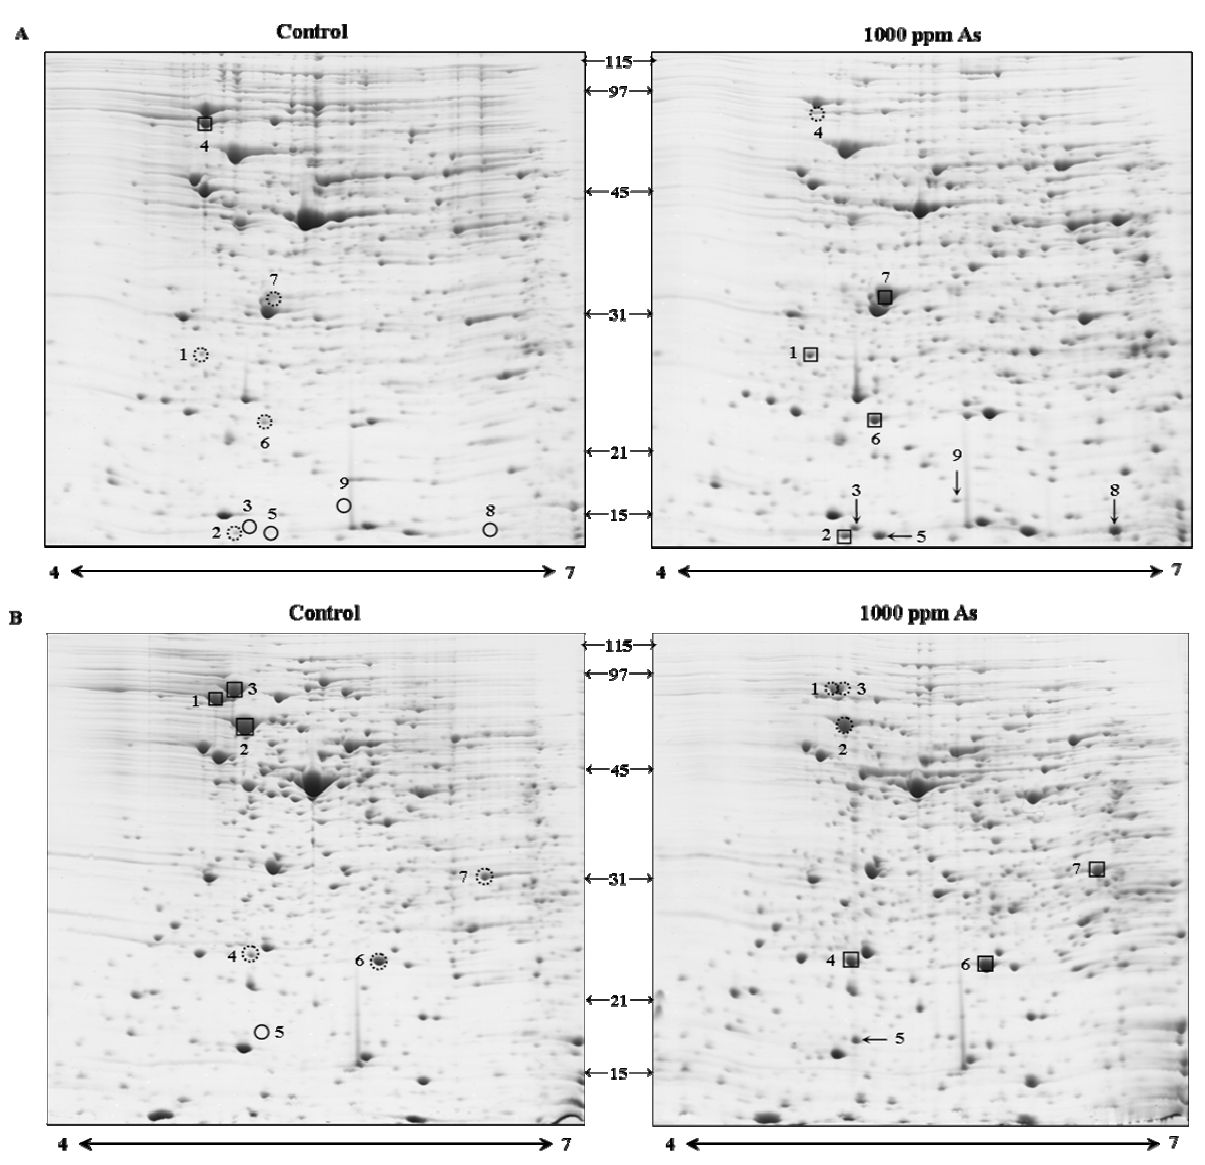
Fig 1 . 2D profile of Pseudomonas fluorescens biotype F (A) and Pseudomonas fluorescens CECT 378 (B) presenting the dif- ferentially expressed proteins in the presence or absence (control) of 1000 ppm of arsenic. The values of the weight standards are situated between the gels. Major protein spots upregulated in each case are marked by squares, while the downregulated ones are marked by a circle of dots. The absence of proteins is indicated by a circle of a solid line, while the new proteins – by an arrow. The numbers show the relative position of the differentially expressed spots described in Tables 1 and